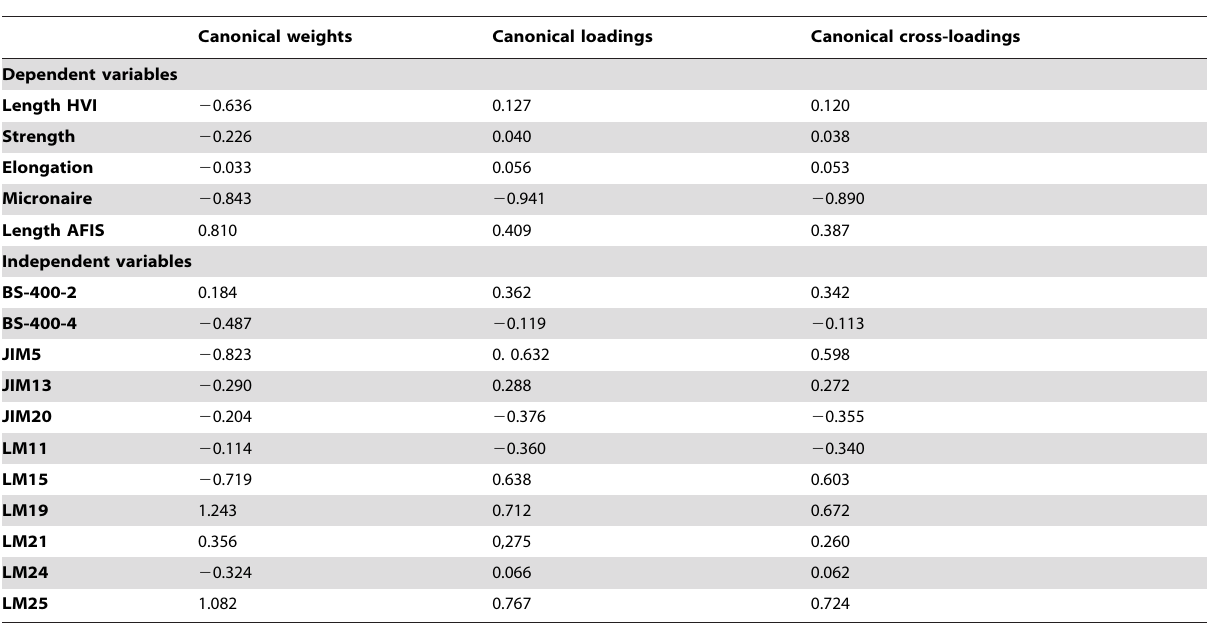
Table 6. Canonical weights, loadings, and cross-loadings for the first canonical function.